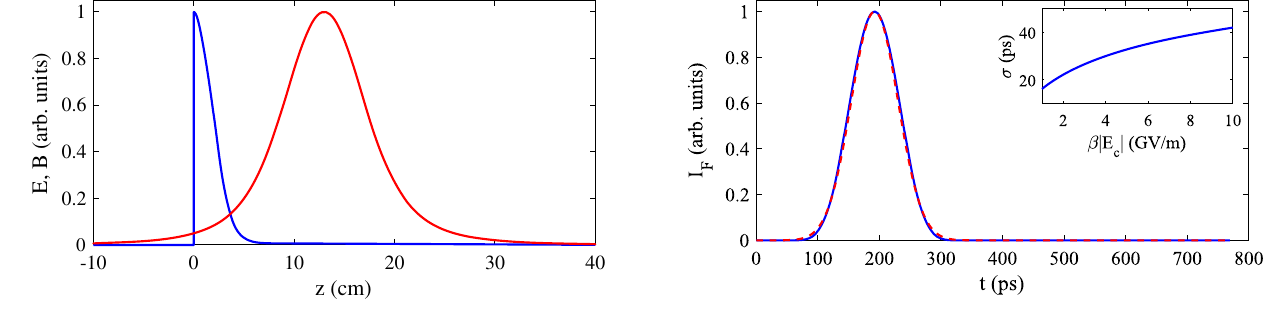
FIG. 6. Emission profile within one rf cycle based on Eq. (1) (blue solid line) and its Gaussian distribution approximation (red dashed line). Inset: The standard deviation of the Gaussian distribution as a function the maximum microscopic cathode